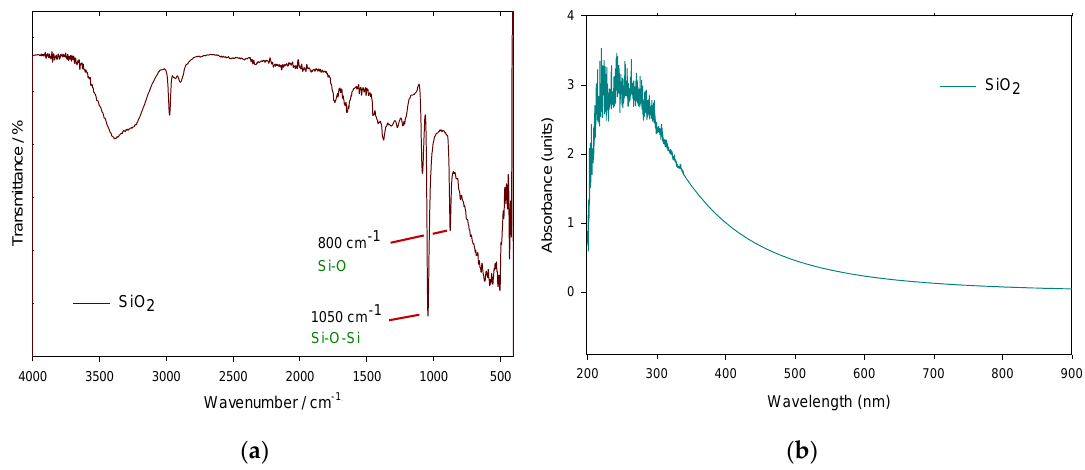
Figure 7. (a) IR spectrum and (b) Optical absorption spectrum of SiO 2 NPs. Figure 7. ( a ) IR spectrum and ( b ) Optical absorption spectrum of SiO 2